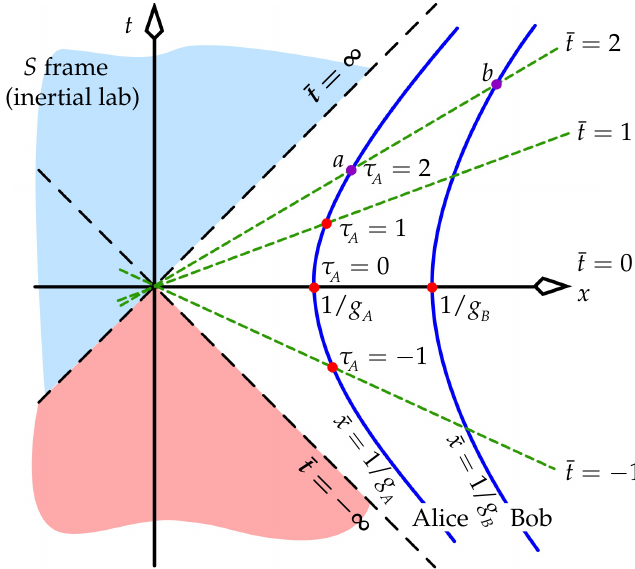
Figure 3. An event’s value of ¯ t is defined to be the proper time τ shown on the master clock (chosen A to be Alice’s) when that event occurs for Alice. The event’s ¯ x is the value of ¯ x of the observer present ) , and event at that event—which is that observer’s value of x at t = 0. Event a has ( ¯ t , ¯ x ) = ( 2,1/ g A ) . No signal can reach Alice and Bob from the blue region: it is “below the b has ( ¯ t , ¯ x ) = ( 2,1/ g B horizon”. Alice and Bob see all events in the red region, but they say that none of those events were simultaneous with any event on their world